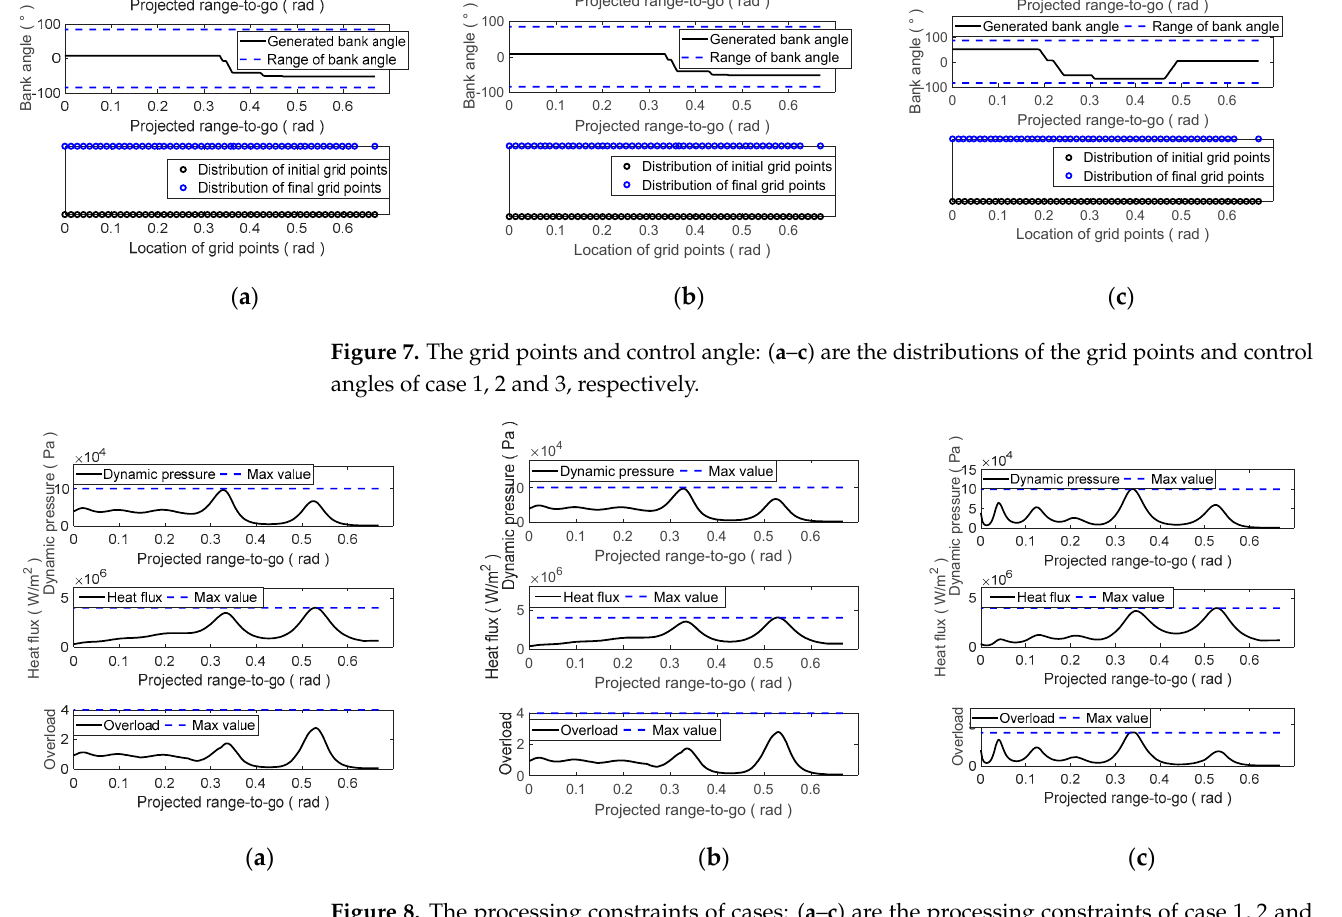
Figure 8. The processing constraints of cases: ( a – c ) are the processing constraints of case 1,2, and 3, respectively.